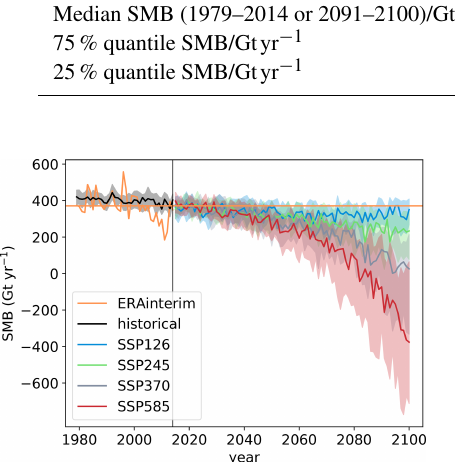
(Fig. 2, black) because the coarse horizontal resolution ham- pers the representation of the observed blocking and its in- creased activity (Davini and D’Andrea,